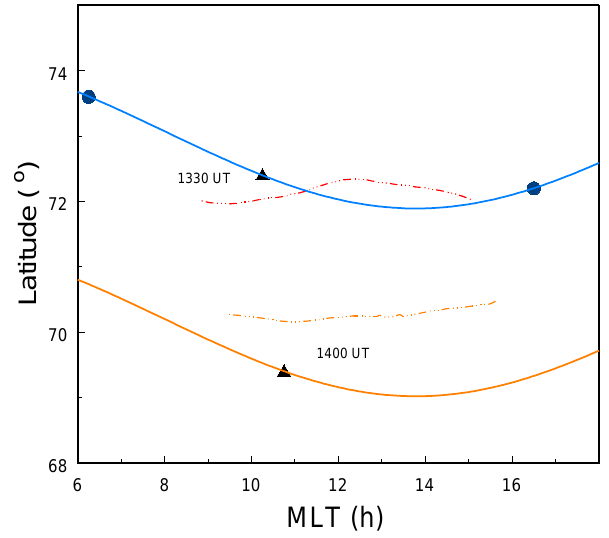
Fig. 6. The location of the polar cap boundary at 13:30 UT (upper curve, solid line), estimated from the Goose Bay radar data (triangle symbol) and the convection reversal boundary derived from DMSP F13 plasma drift data (two circles). The latitude of the boundary ( y - axis) is plotted as a function of magnetic local time ( x -axis). The lower curve (solid line) shows the location of the PCB at 14:00 UT, determined from the polar cap expansion rate given by the Goose Bay radar data. The triangle symbol represents the location of the polar cap boundary derived from the Goose Bay radar data at 14:00 UT. The two dash-dot lines represent the location of the PCB derived from the estimated magnetopause location (using Equator-S and Geotail satellite data) when mapped to the ionosphere using the Tsyganenko 1996 magnetospheric field model. The high-latitude line represents the boundary at 13:30 UT, the lower latitude line the boundary at 14:00